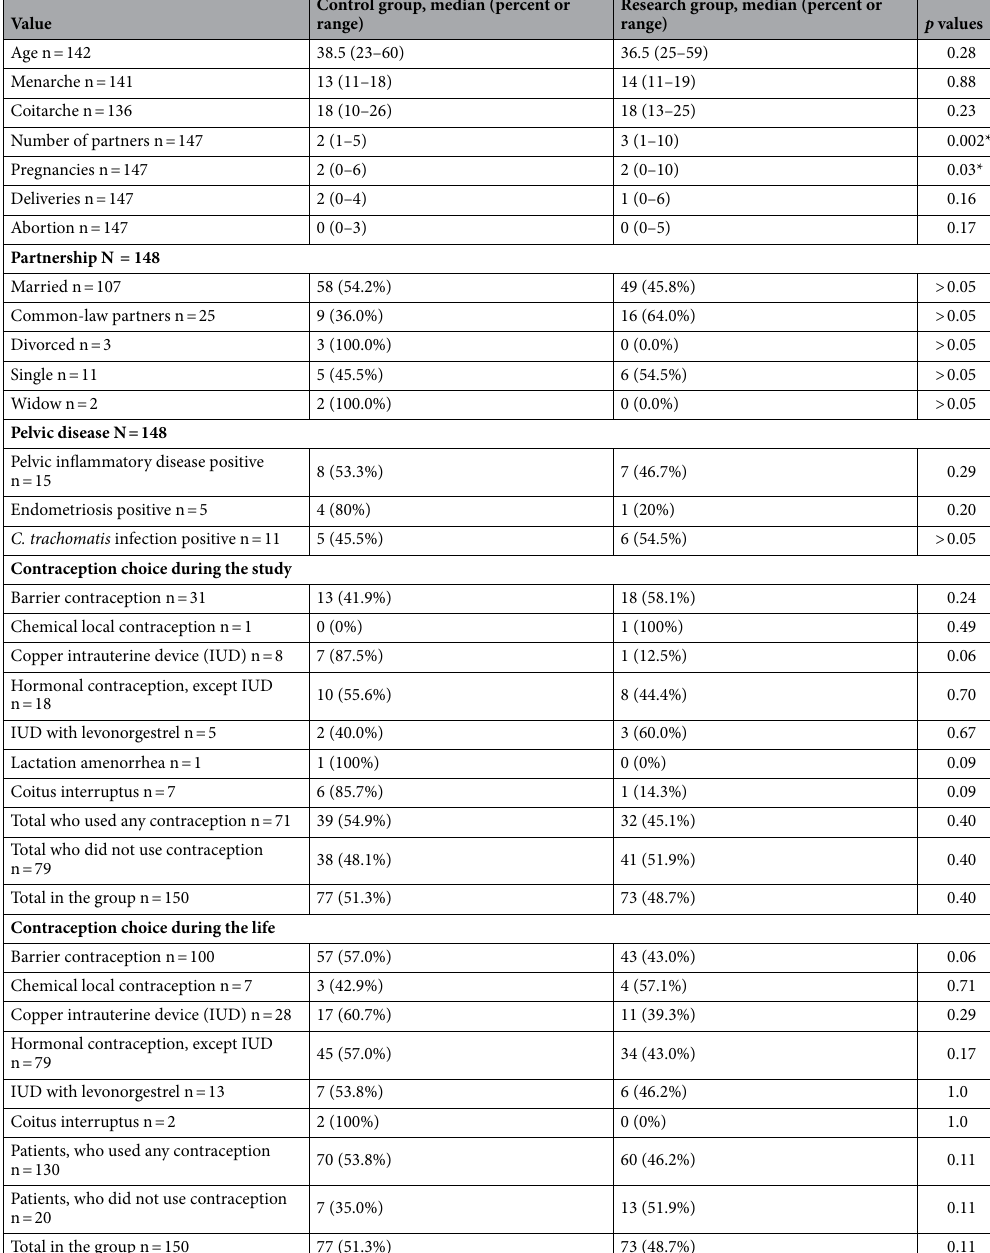
Table 1. Demographic and clinical characteristics of the patients in research and control groups. *— statistically significant difference. Values are medians with inter-quartile ranges for continuous data and frequency (percentage, %) for categorical data. The listed p values of statistical tests were calculated using Mann–Whitney U test for continuous data and the χ 2 or Fisher’s exact test for categorical data. Numbers slightly vary within groups due to missing